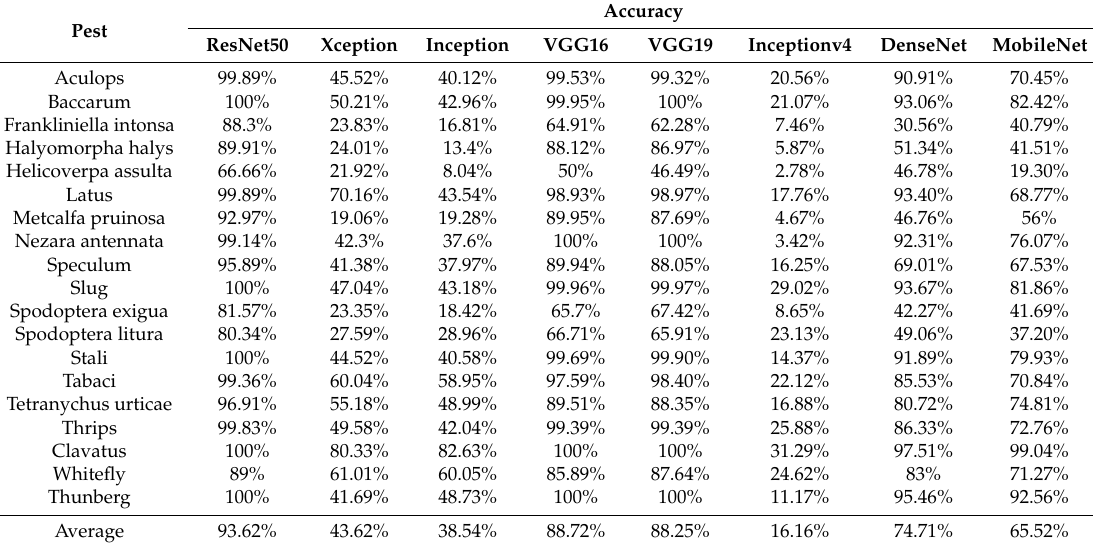
Table 4. Accuracy comparison of each pre-trained model in pepper pest.